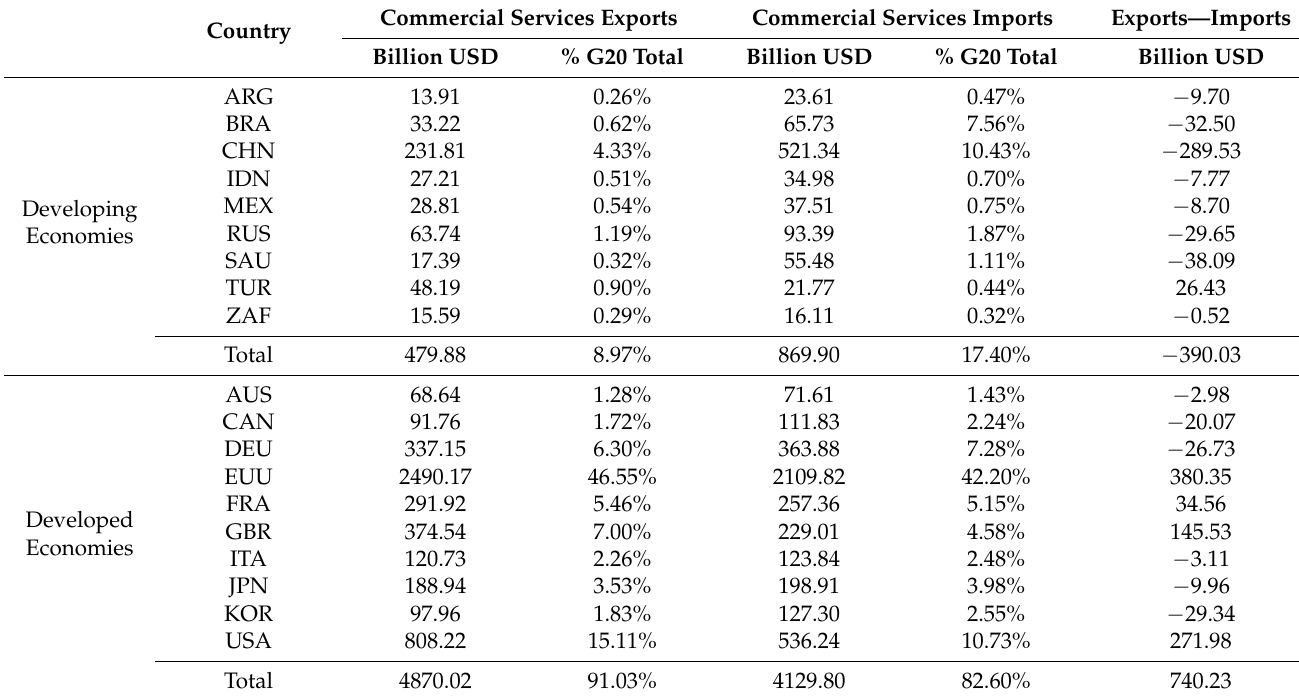
Table 3. The volume of exports, imports, and exports minus imports of commercial services for the G20 nations in 2018.